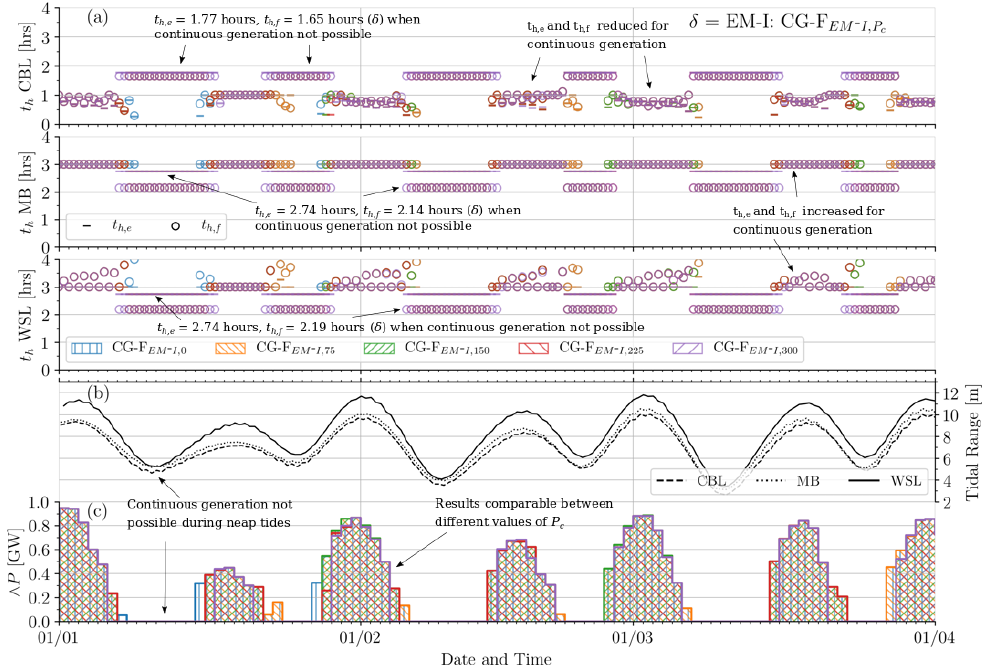
Figure 7. Temporal operation characteristics of the tidal power plant system in applying flexible controls to optimise towards continuous generation, with δ = EM-I, an inflexible energy maximisation default (CG-I EM - I , P ). For all three power plants, (a) indicates holding periods t h , e and t h , f per tidal c